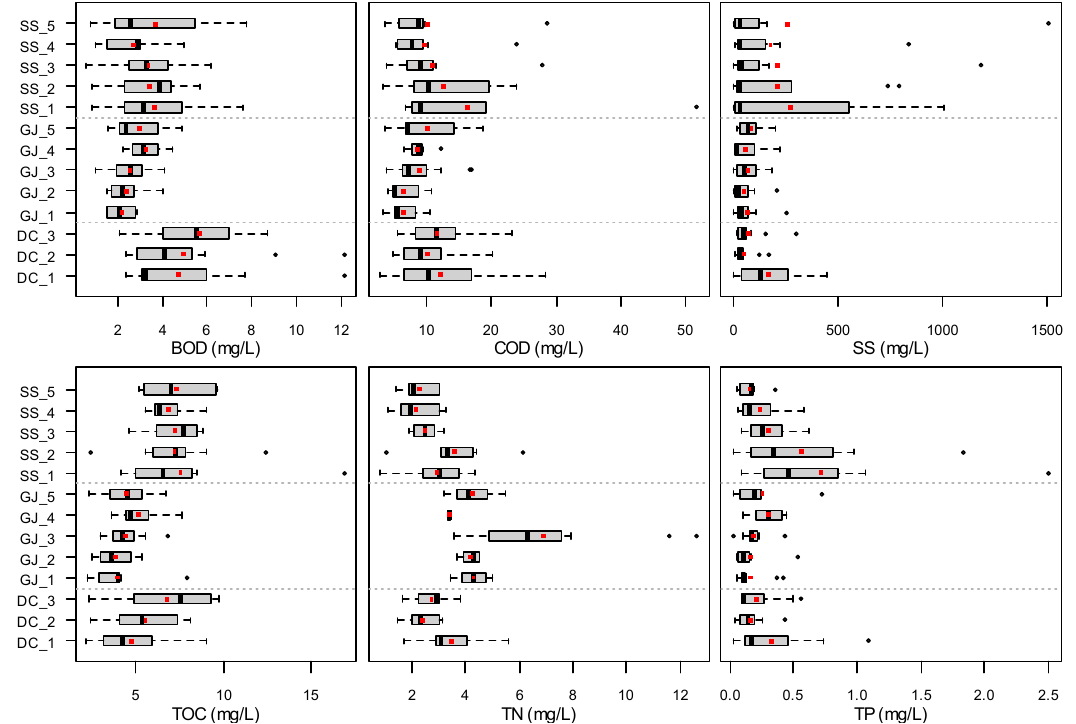
Figure 5. Boxplot of event mean concentration at each monitoring site during rainy days over the monitoring period (red dot: average).